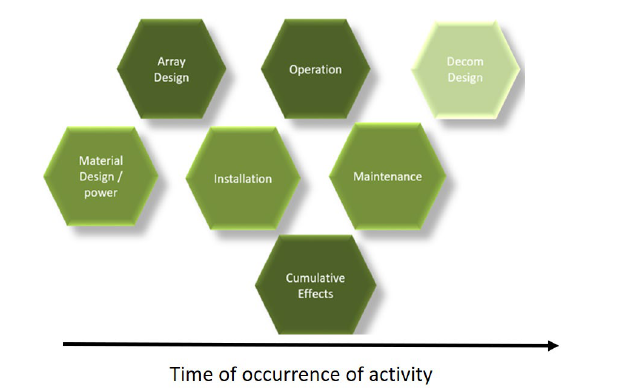
Fig. 2. The ecological impacts for each stage of development with the darker the colour representing higher levels of